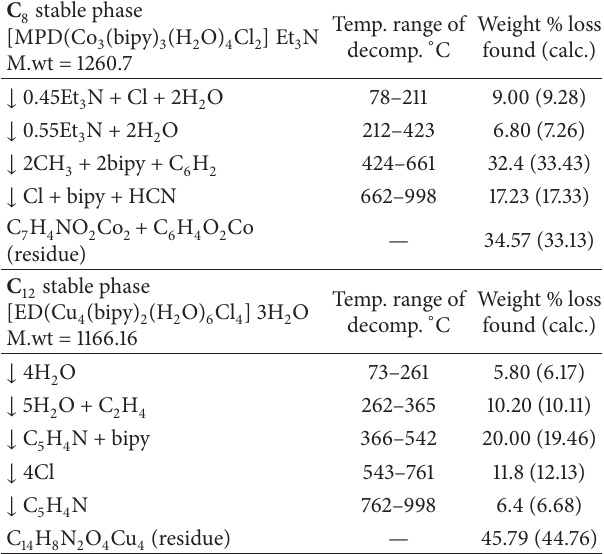
Table 6: Thermal decomposition of the copper complexes ( C 8 and C 12